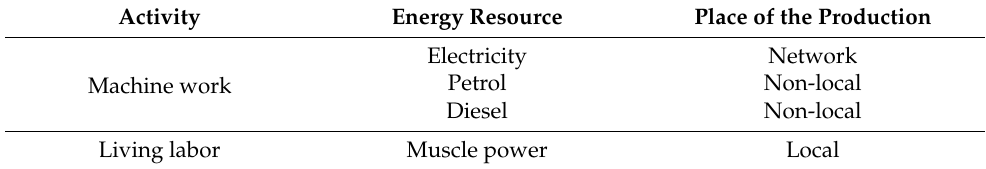
Table 2. Activities, energy resources, and place of the production of agriculture.